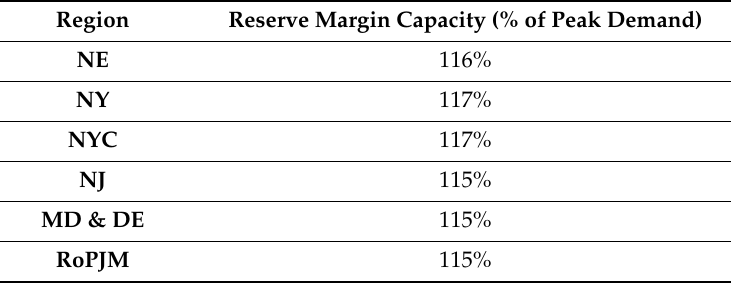
Table A5. Reserve Margin Percentages.